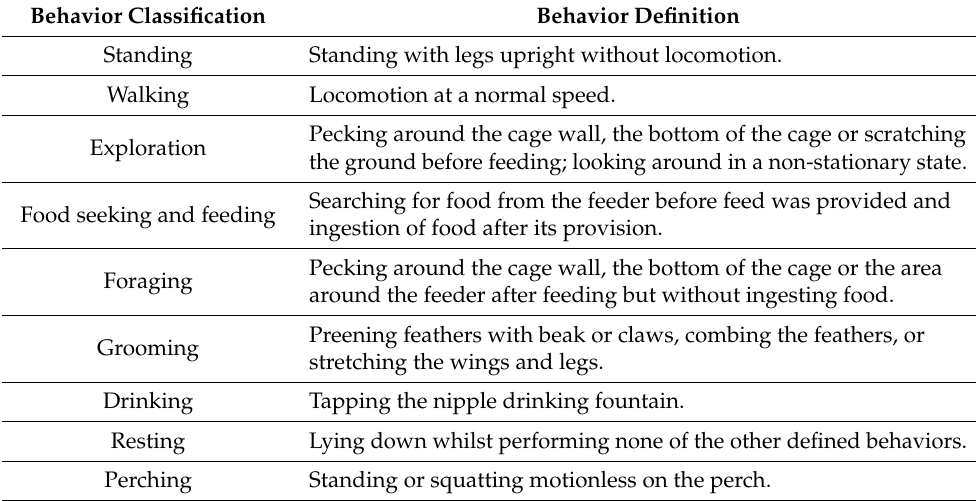
Table 1. Classification and definition of in situ